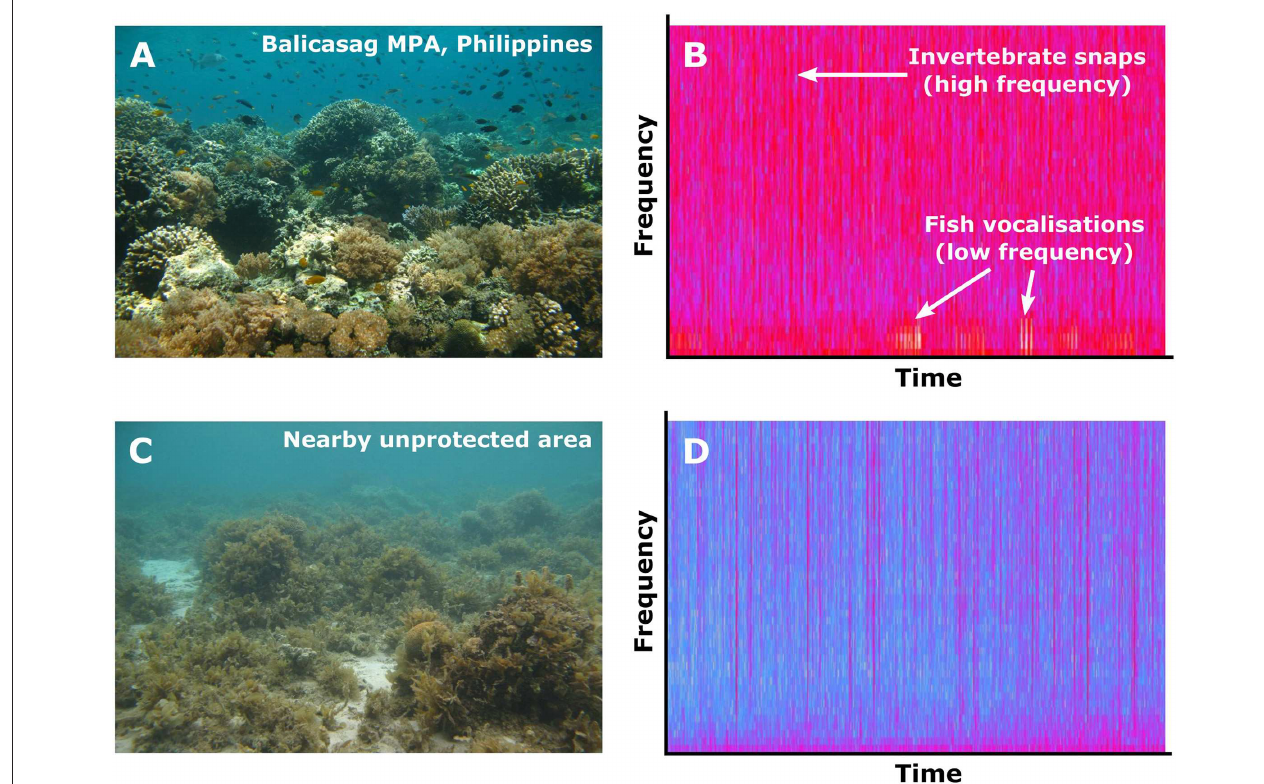
FIGURE 5 | Visual and acoustic comparisons of (A,B) Balicasag Marine Protected Area, a fully-protected reef in Central Philippines, and (C,D) a nearby unprotected, overfished reef. (A,C) Show representative pictures of each habitat. (B,D) Spectrograms showing sound intensity (red colors are high intensity; blue colors are low intensity) at different frequencies (0–7kHz) over time (4s). Recordings are explored further in Piercy et al.